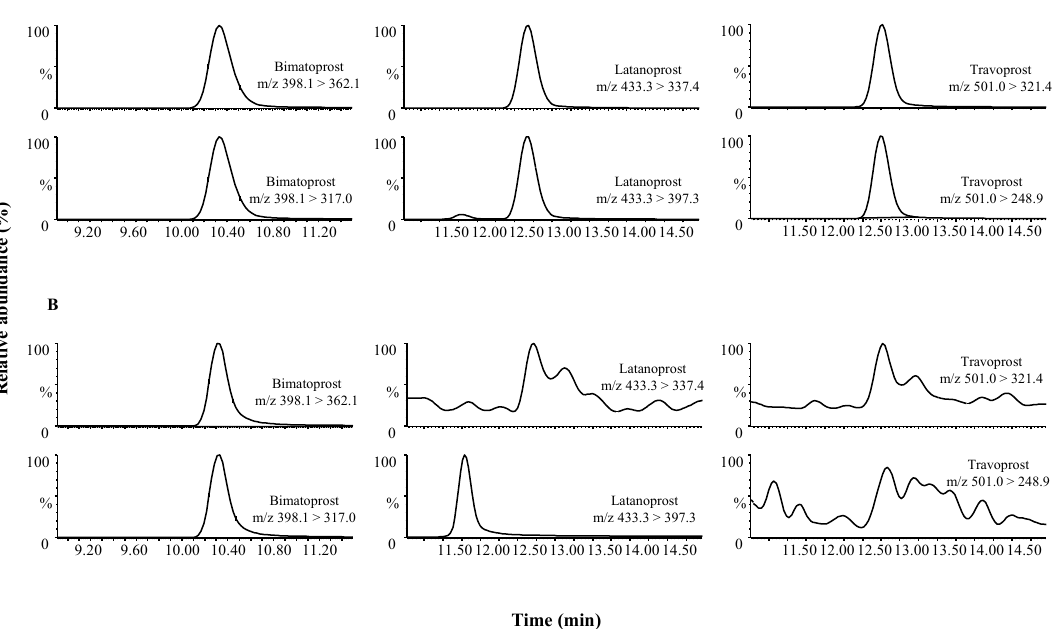
Figure 2. HPLC-MS/MS chromatograms of ( A ) the quantifying and qualifying transitions of all three prostaglandin analogs (450 µ g/g) and ( B ) the quantifying and qualifying transitions obtained following the extraction of eyelash enhancing product containing 629.3 µ g/g of bimatoprost.